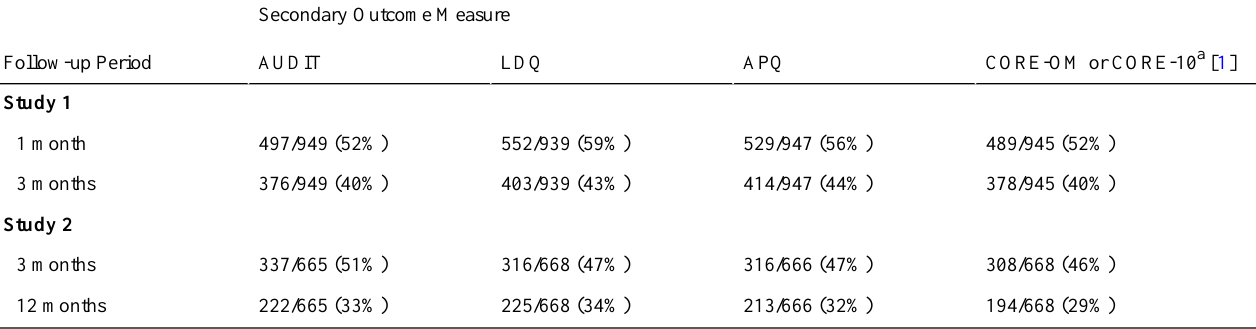
Table 2. Follow-up rates in groups randomized to four secondary outcome